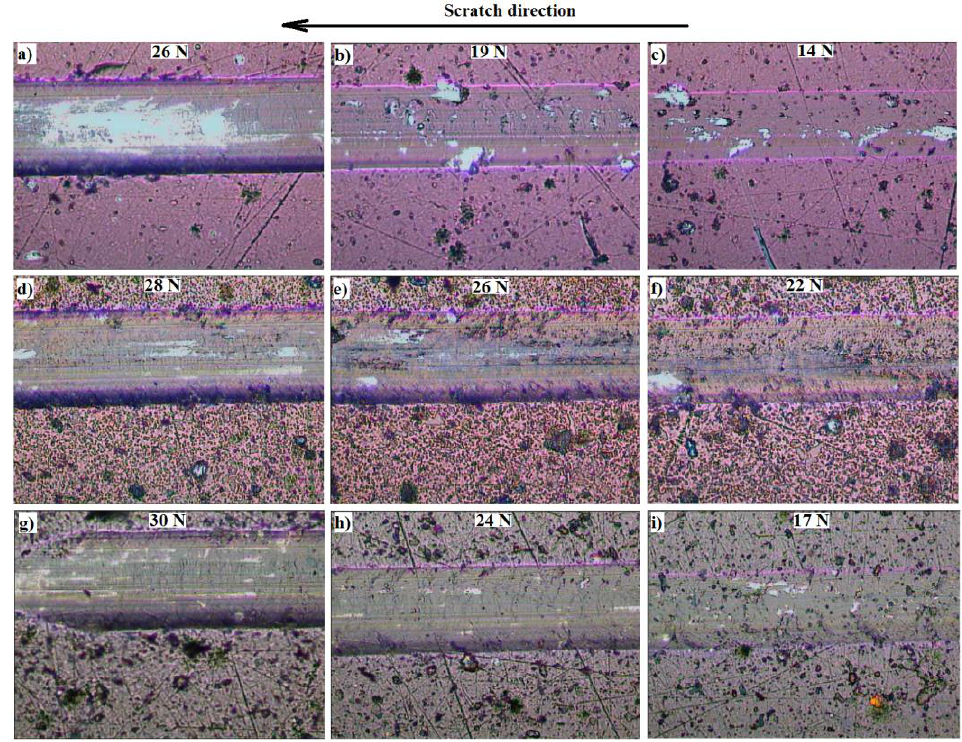
Figure 9. Scratches of the samples deposited at I Al : 70 A ( a – c ); 2–80 A ( d – f ); 3–90 A ( g – i ).